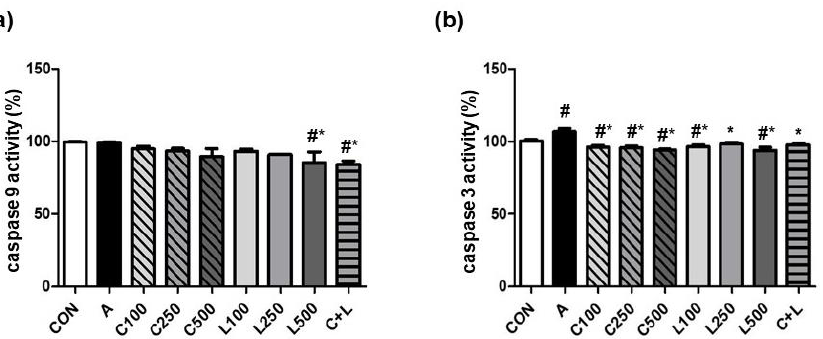
Figure 4. Effects of aspirin, CPC, and/or LBP on apoptotic markers ( a ) caspase 9 activity and ( b ) caspase 9 activity. CON: control group, A: aspirin-induced group, C: CPC treated group, L: LBP treated group. Data are mean ± SD ( n = 3). # p < 0.05 compared with the CON group. * p < 0.05 compared with the A group.